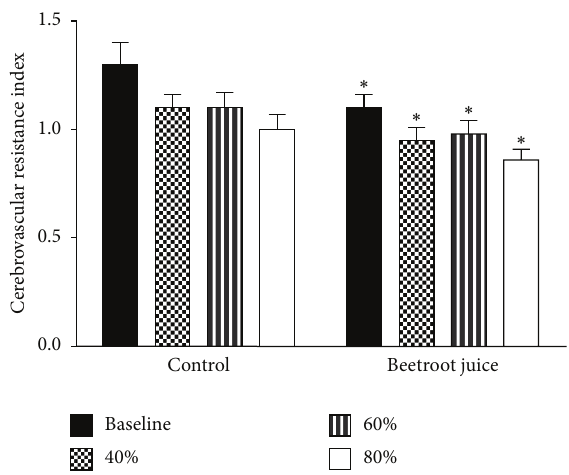
Figure 2: Effects of beetroot juice treatment on middle cerebral arterial cerebrovascular resistance index. Bars represent means ± standard errors for middle cerebrovascular resistance index, com- puted as the ratio mean arterial blood pressure/mean middle cere- bral artery blood flow velocity, expressed in mmHg ⋅ cm −1 ⋅ s −1 . The study subjects were 12 healthy, normotensive young adult African- American females. Left panel: placebo control orange juice treat- ment. Right panel: beetroot juice treatment. ∗ Difference between control and beetroot juice treatments statistically significant at 𝑃 < 0.05 .